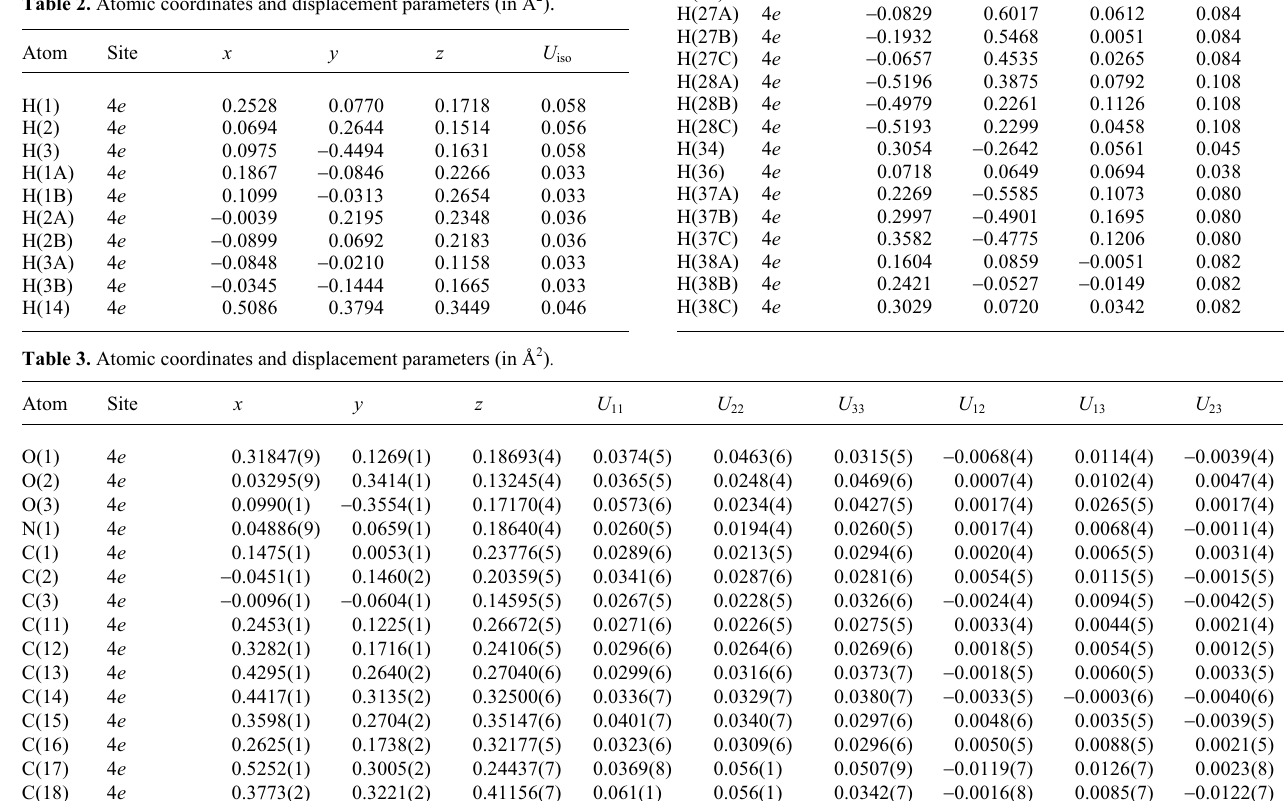
Table 2. Atomic coordinates and displacement parameters (in Å 2 ) .